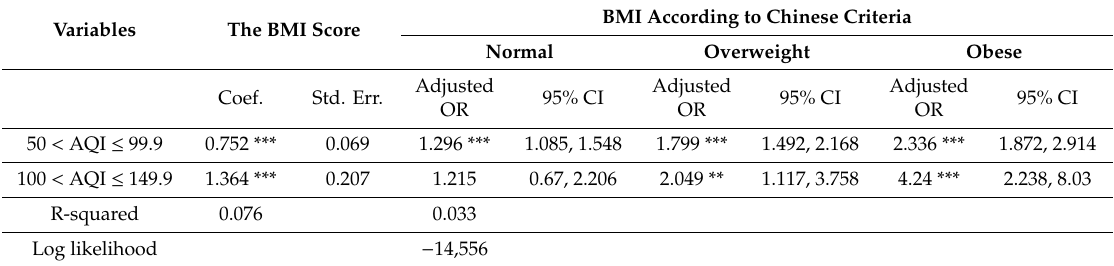
Table 6. E ff ect of Air Quality Index (AQI) on Body Mass Index (BMI): categorical AQI levels.